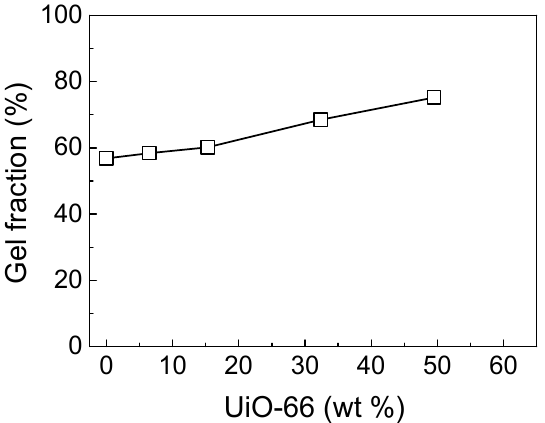
Figure 6. Gel fractions of the UiO-66 dispersed DSPD films as a function of UiO-66 content. (DSPD with 2.5 wt.% silane content was used for composite film fabrication).